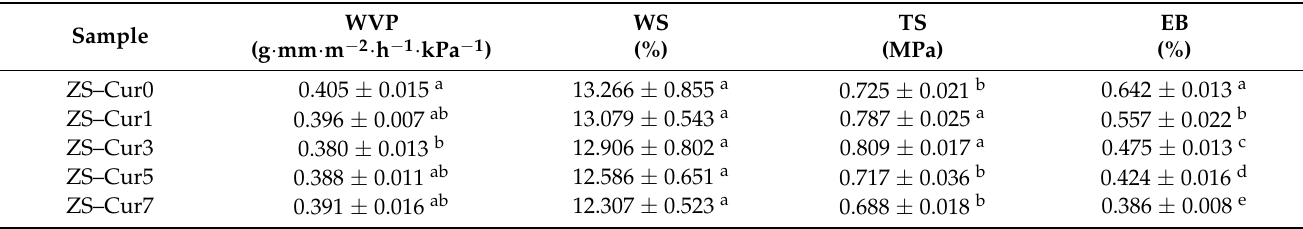
Table 1. Physical properties of zein/shellac film loaded with different curcumin contents.